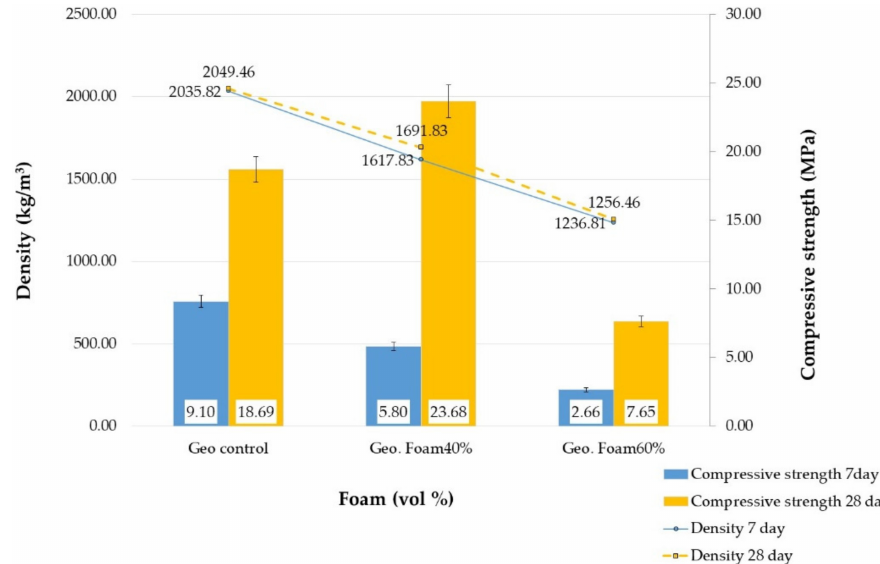
Figure 5. Compressive strength of foamed geopolymer.